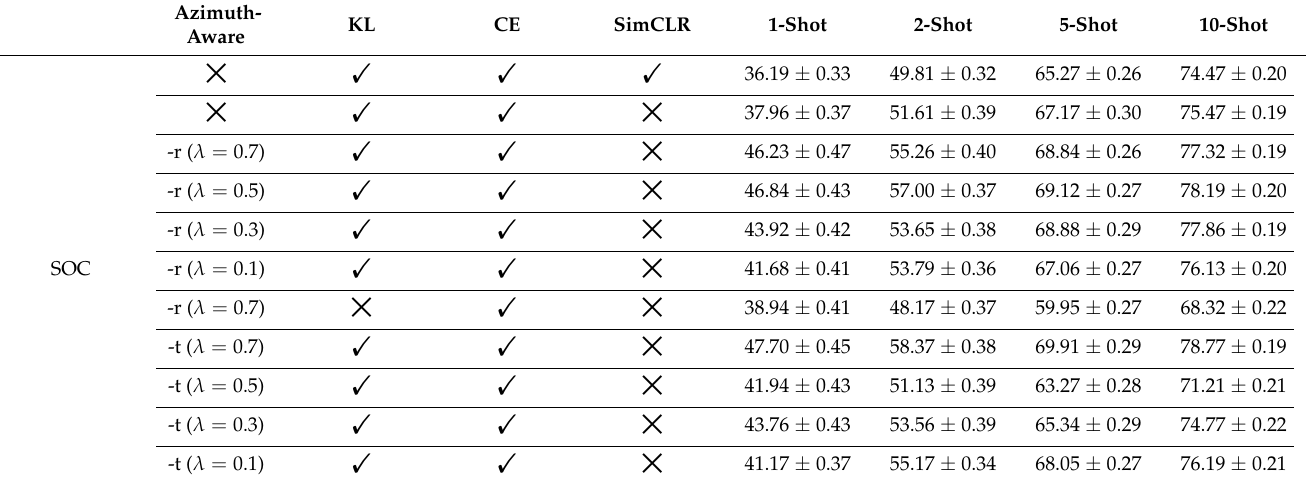
Table 5. Influence of different loss module among SOC